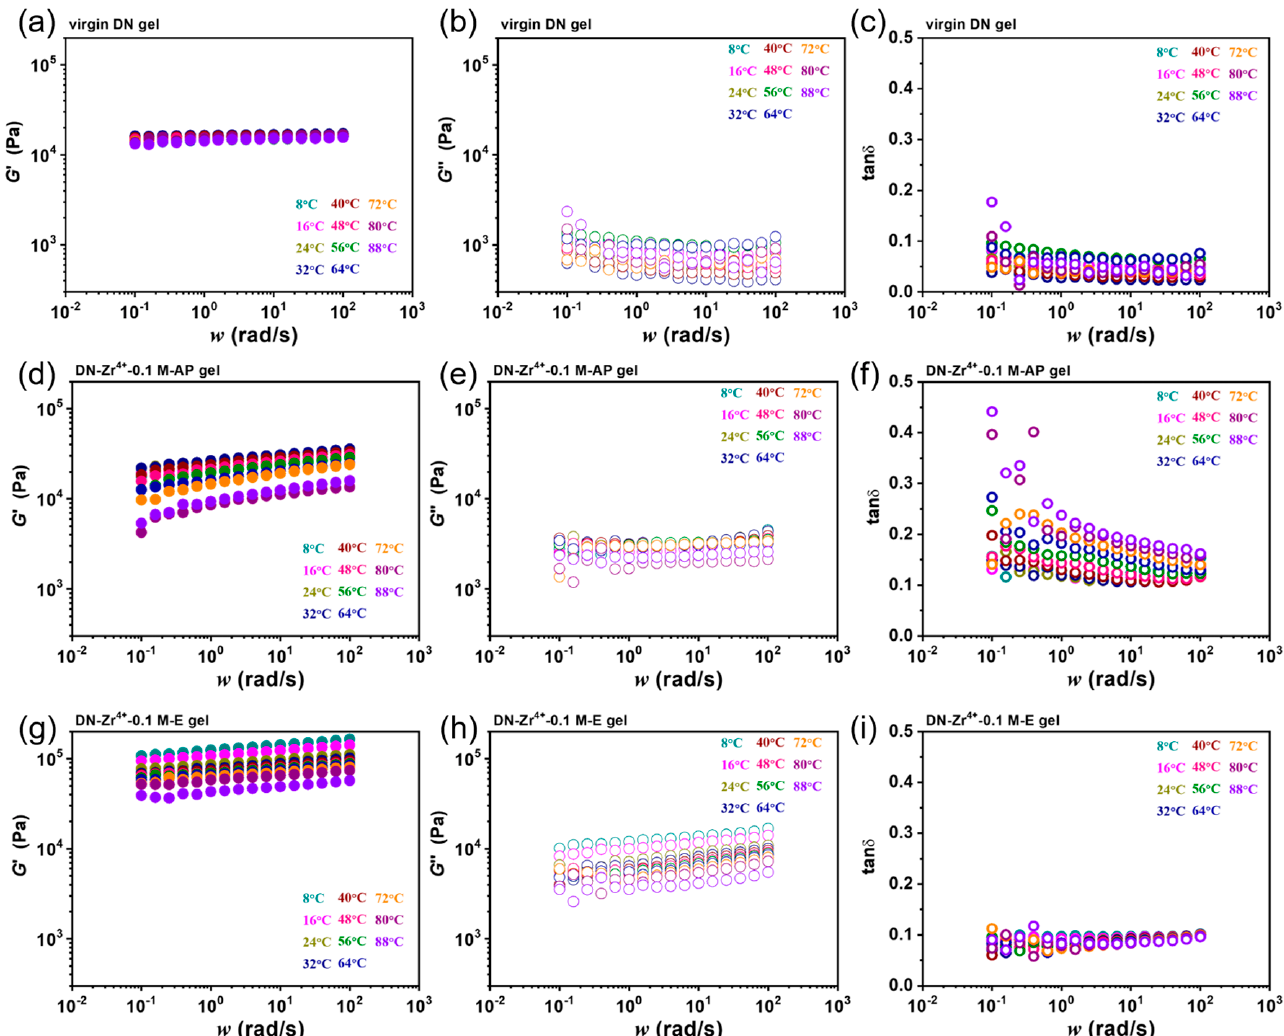
Figure 2. Linear dynamic mechanical behavior of virgin DN, DN − Zr 4+ − 0.1 M − AP and DN − Zr 4+ − 0.1 M − E hydrogels. Frequency dependence of ( a ) storage moduli G ′ , ( b ) loss moduli G ″ and ( c ) loss factor tan δ for virgin DN hydrogels. Frequency dependence of ( d ) storage moduli G ′ , ( e ) loss moduli